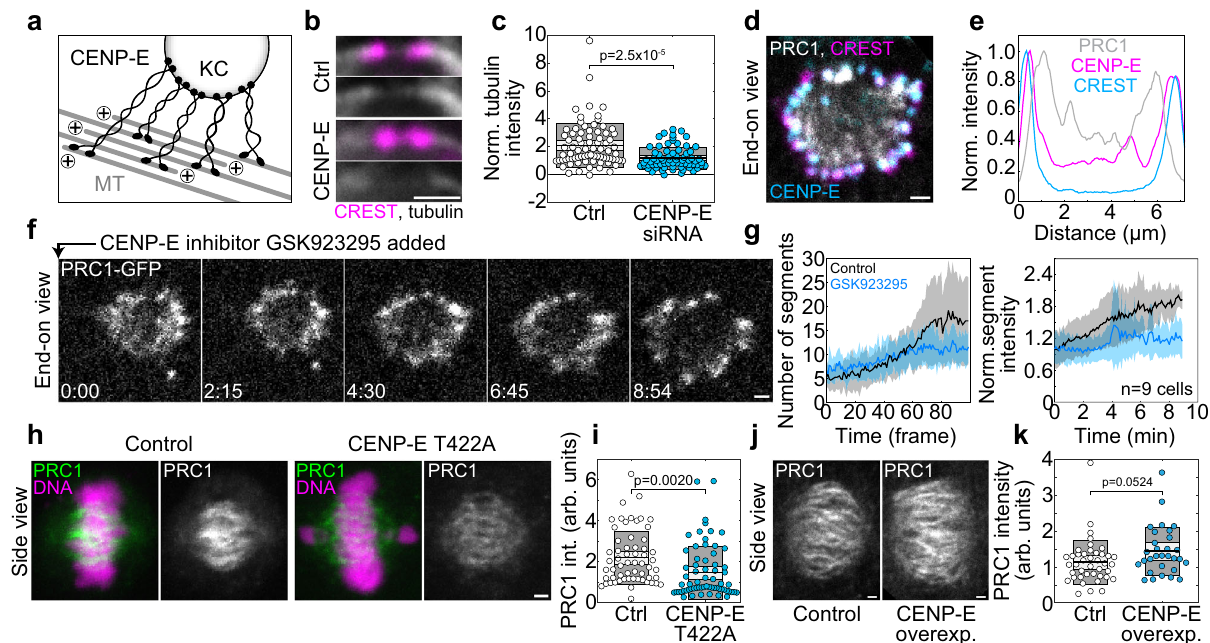
Fig. 3 | CENP-E promotes overlap bundle formation. a Scheme of CENP-E-driven microtubule bundling. b Region around a kinetochore pair immunostained for CREST (magenta) and tubulin (white) in an untransfected HeLa cell, control (top) and after CENP-E depletion (bottom), merged channels and only tubulin. c Mean tubulin intensity at the bridging fi ber center in control and CENP-E depleted cells, normalized to the cytoplasmatic anti-tubulin intensity; n =78/10 bundles/cells (control) and 70/14 (CENP-E depletion), from 3 independent immunostainings. d Cross-section of a vertical prometaphase spindle immunostained for CREST (magenta) and CENP-E (cyan) in a HeLa-Kyoto cell expressing PRC1-GFP (white). e Lineintensityplotsof PRC1-GFP,CRESTand CENP-Efromthe spindle shownind, normalized to the corresponding maximum value. The linewasdrawn through the spindle cross-section center, with a thickness of 1/3 of the spindle cross-section. f Time-lapse images of a midplane of a vertical prometaphase spindle in a HeLa- KyotocellexpressingPRC1-GFP(white),afteradditionoftheCENP-EinhibitorGSK- 923295. g Number of PRC1 segments (left) and normalized mean intensity of